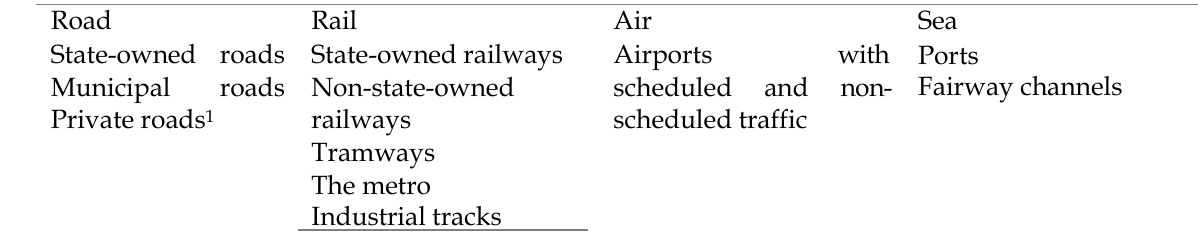
Ports Fairway channels